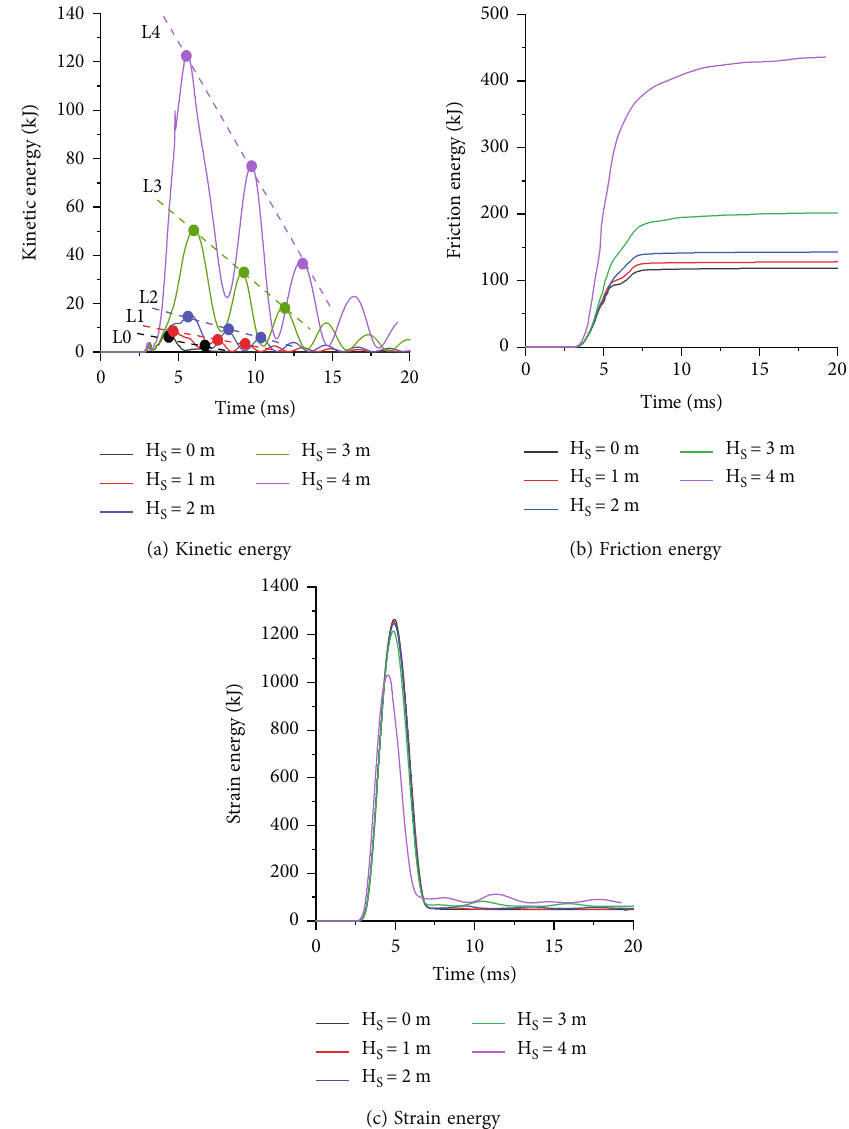
Figure 15: Energy evolution curves (1 ~ 5 working